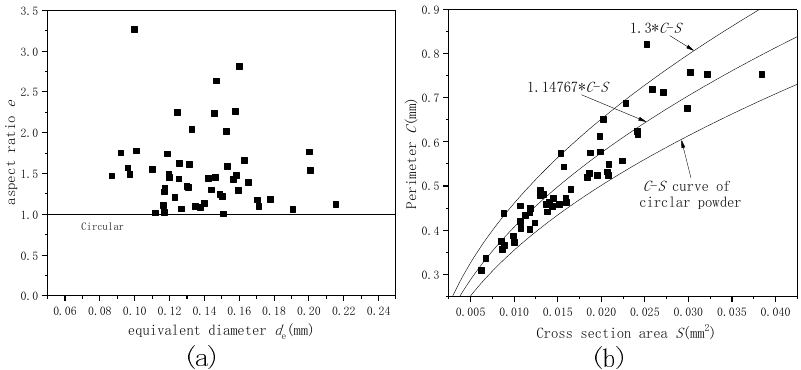
Figure 5. Wick structure morphology of anti-gravity heat pipe; ( a , b ) large phase-change chamber end and ( c , d ) small phase-change chamber end.